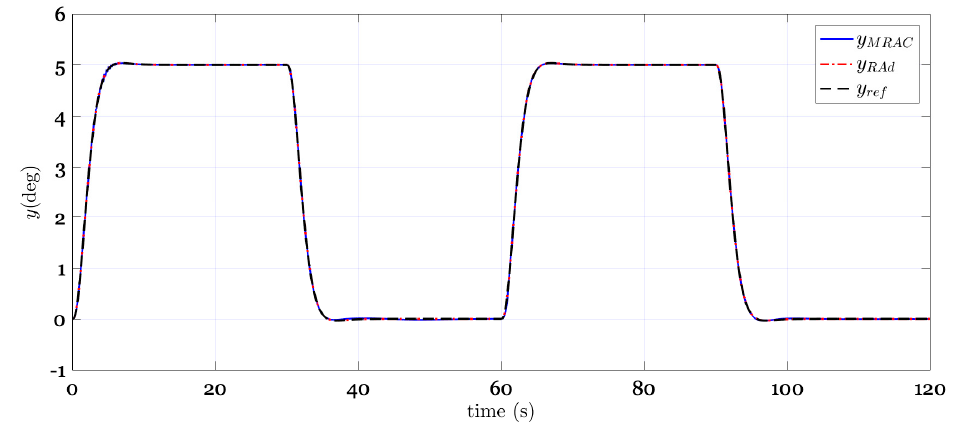
Figure 5. Tracking performance for MRAC and robust adaptive controller with ρ λ = ρ θ =